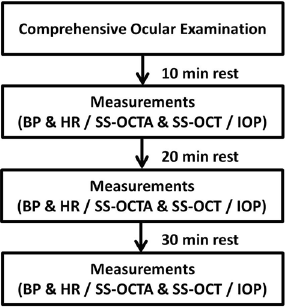
Figure 5. Flow diagram of all subjects through the study. BP blood pressure; HR heart rate; SS-OCTA swept source optical coherence tomography angiography; SS-OCT swept source optical coherence tomography; IOP intraocular